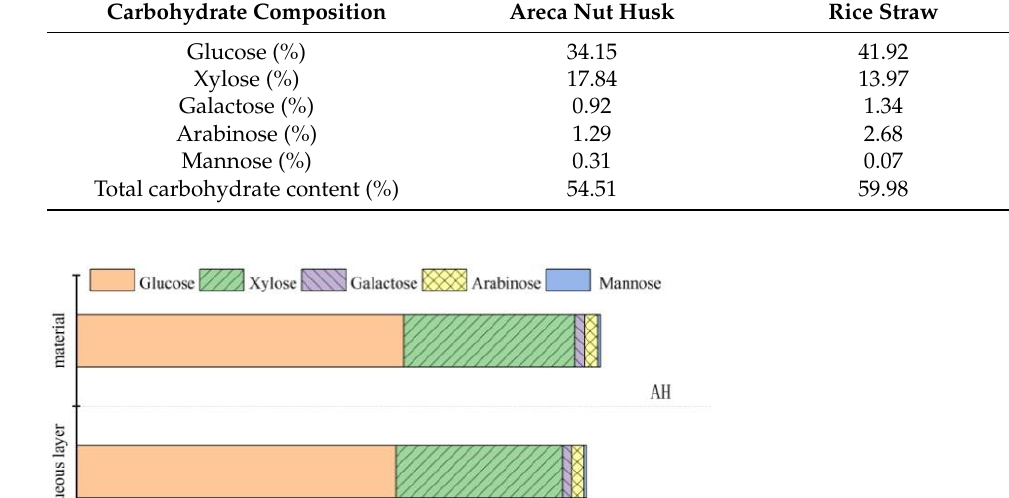
Table 9. Carbohydrate compositions in the aqueous flour after phase separation. Carbohydrate Composition